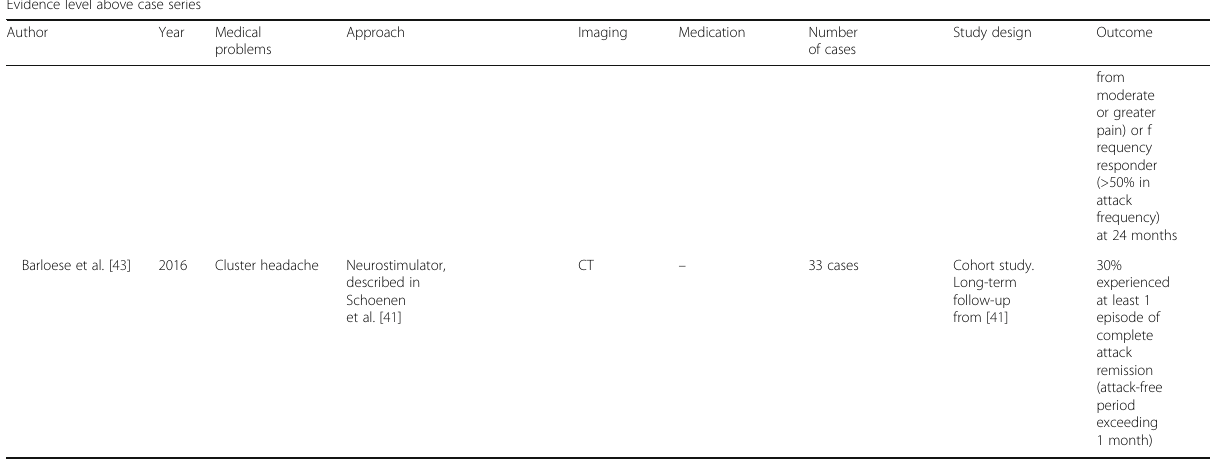
Table 2 Studies with evidence level above case series in SPG block, radiofrequency ablation and neurostimulation (Continued) Evidence level above case